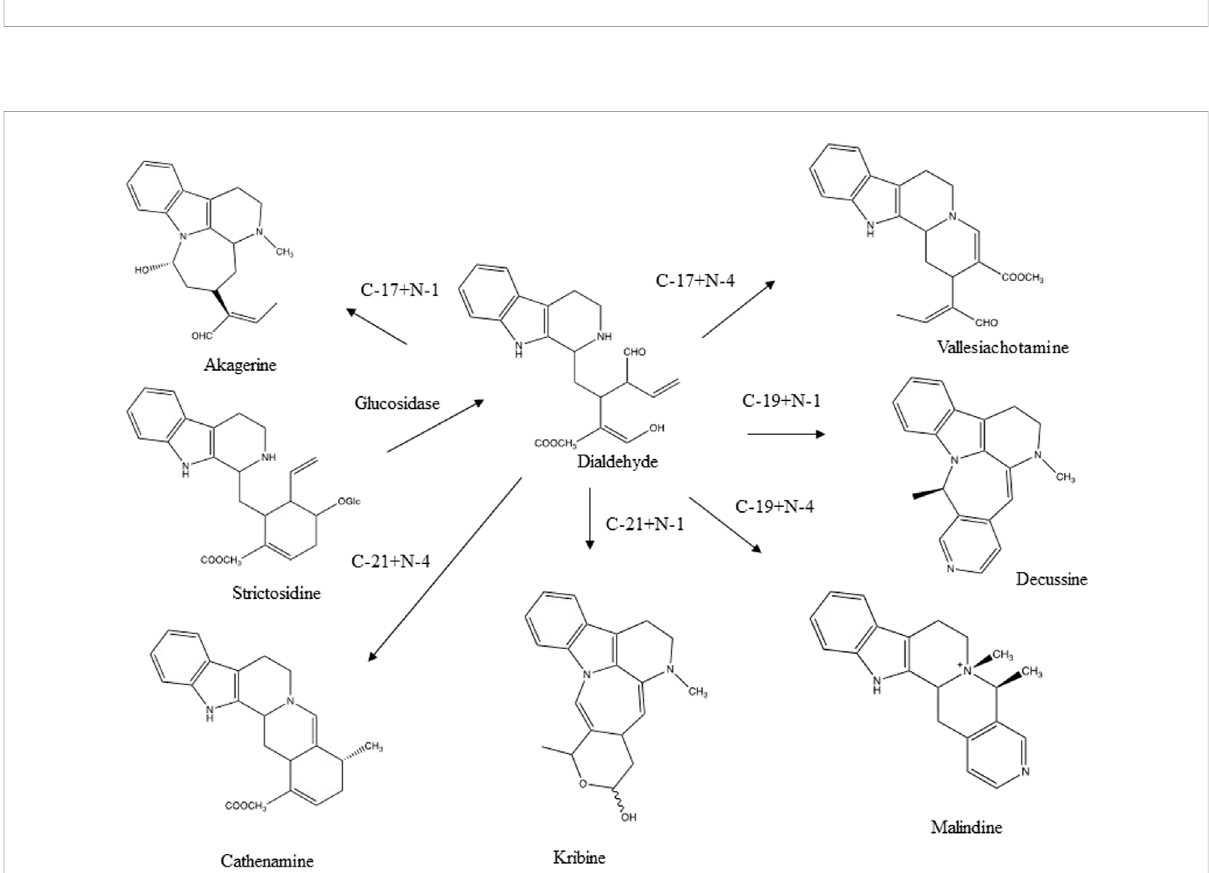
Various skeletons of terpenoid indole alkaloids formed through the intramolecular reaction of the aldehyde group and an amine function after glucolysis of strictosidine (Verpoorte,